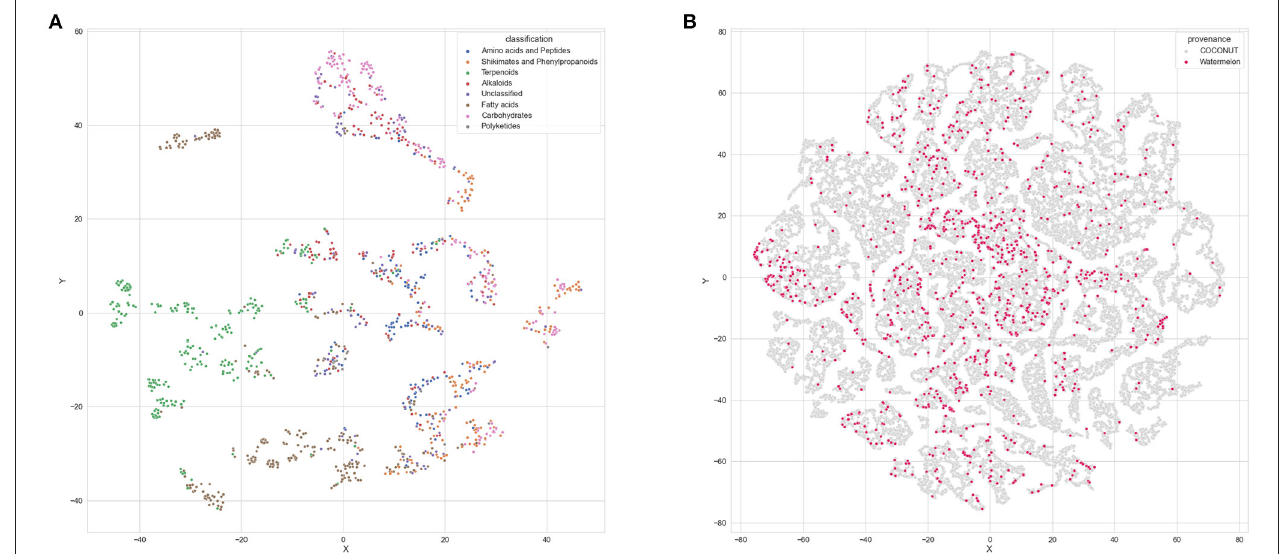
FIGURE 11 | Graphical representation of the chemical space covered by watermelon natural products. (A) t-SNE plot of the known watermelon chemical space. Every point represents one molecule with points colored by their chemical class. (B) t-sne plot of the watermelon compounds (in red) within the known natural products chemical space (in